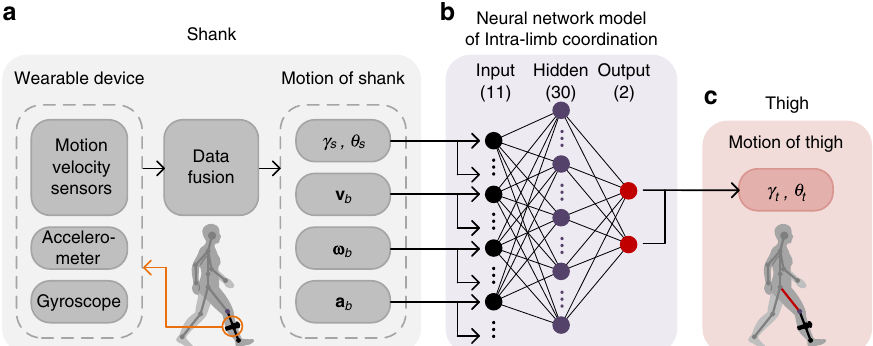
Fig. 2 The principle of lower limb motion capture by single wearable device. a The motion of shank is directly measured by the device worn on the shank. b The neural network model of intra-limb coordination between shank and thigh has 30 hidden neurons and use motion information of shank as the inputs of the network (including shank attitude angles γ s , θ s , motion velocity v b , and the corresponding derivatives angular rate ω b and motion acceleration a b ) and use attitude angles of thigh ( γ t , θ t ) as the outputs of the network. c The thigh motion is determined from the shank motion measured by the wearable device incorporating with the intra-limb coordination